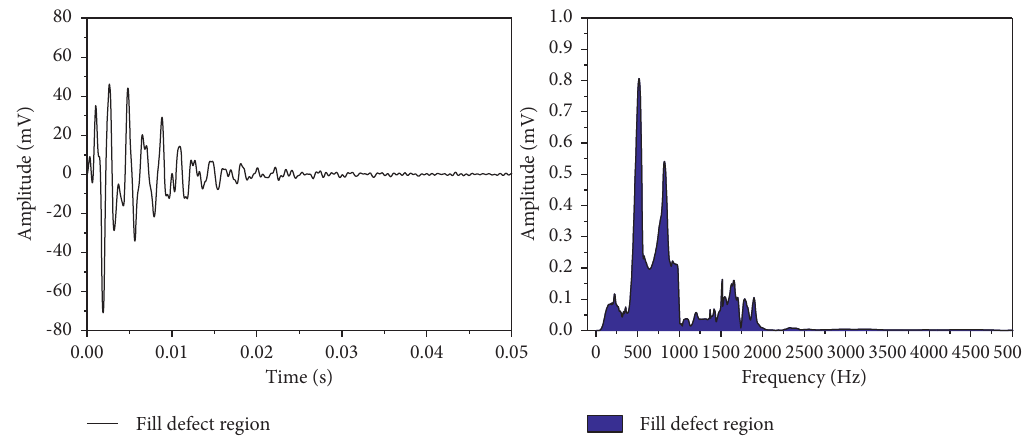
Figure 5: Time history curve and frequency spectrum of experimental